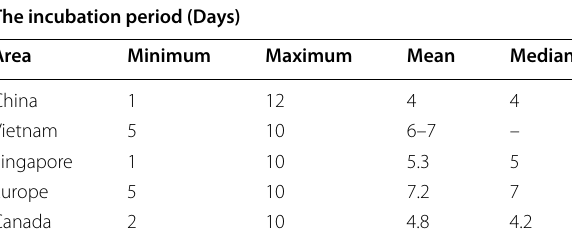
Table 2 Estimated incubation period (days) by